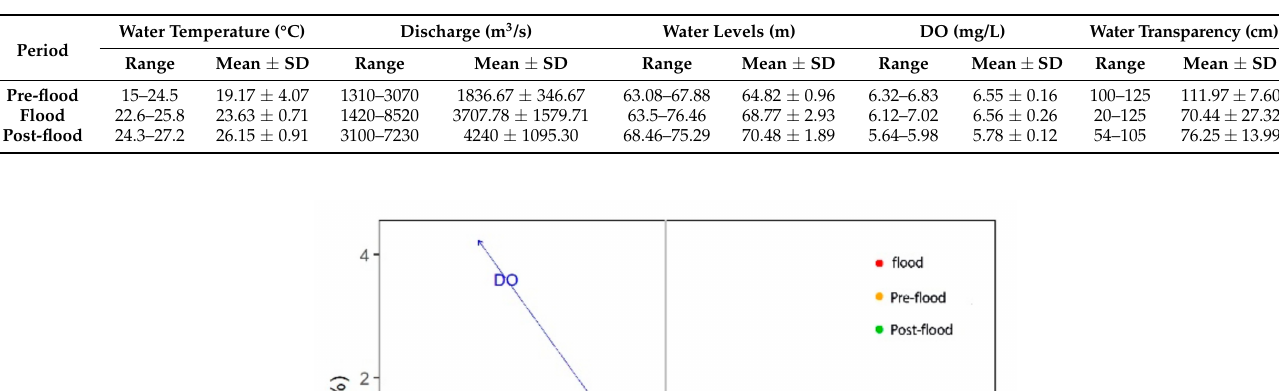
Table 1. Temporal variations in range and mean ± standard deviation (SD) values for water temperature, discharge, water levels, dissolved oxygen (DO), and water transparency in the upper Xijiang in summer 2017.